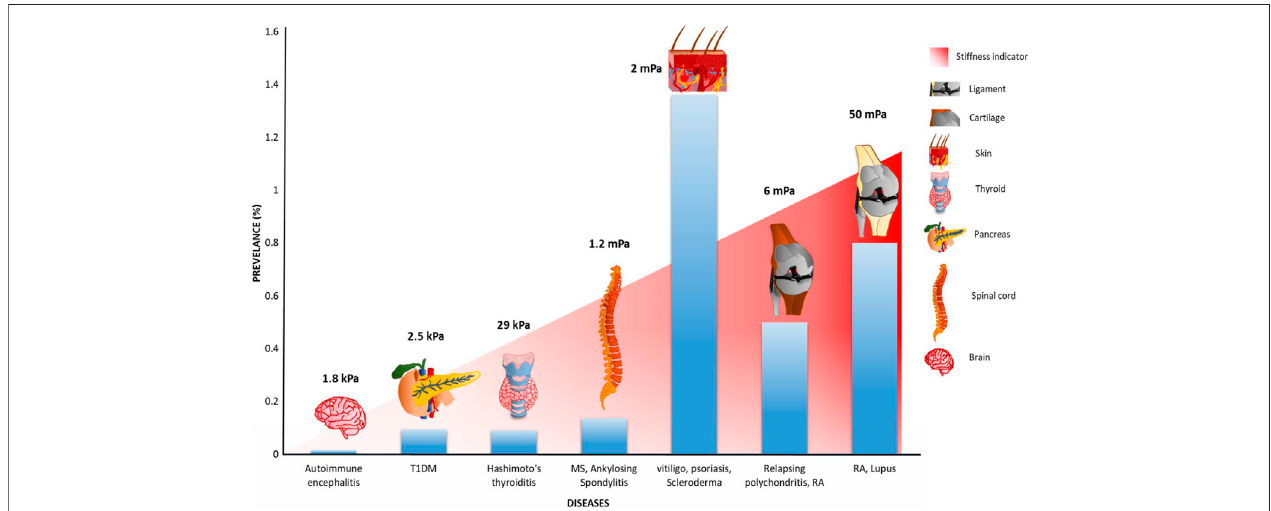
FIGURE 8 | Plausible correlation between the worldwide prevalence ofdifferent autoimmune disorders with organ stiffness: the prevalence percentage of different autoimmune disorders affecting differentially stiff organs has been illustrated. Autoimmune diseases range from autoimmune encephalitis, type 1 diabetes mellitus (T1DM), and autoimmune thyroiditis, which affects softer tissues like the brain, pancreas, and thyroid, respectively, to vitiligo, psoriasis, multiple sclerosis, and lupus scleroderma, which affect stiffer or hard tissues, have been considered for this study. As the fi gure depicts, the trend of autoimmune disease prevalence shows a positive correlation with the different organ stiffness. For example, in the case of autoimmune thyroiditis, the worldwide prevalence rate is approximately 0.1%, which majorlyaffects thethyroidwithtissuestiffness of29 kPa(Guimarãeset al.,2020),whereas, withlupus,whichaffects ligament ( > 5 MPa), theprevalence rateincreasesto 0.8%. Autoimmune encephalitis affected the brain; type 1 diabetes mellitus affected the pancreas; Hashimoto ’ s thyroiditis affected the thyroid; multiple sclerosis and ankylosing spondylitis affected the spinal cord; vitiligo, psoriasis, and scleroderma affected the skin; relapsing polychondritis and rheumatoid arthritis affected the cartilage; rheumatoid arthritis and lupus affected the ligament (Chopra et al., 2013; Baldini et al., 2017; Resende de Paiva et al., 2017; Dubey et al., 2018; Parisi et al., 2020; Siebert, Raj, Tsoukas; Walton et al., 2020; Almutairi et al., 2021; Barber et al., 2021).